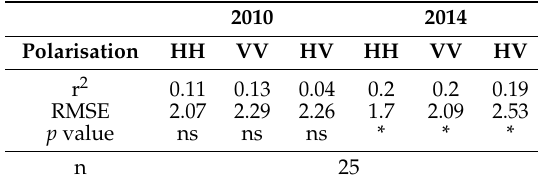
Table 7. Statistical relationships between S-band backscattering ( σ °) to average tree diameter.